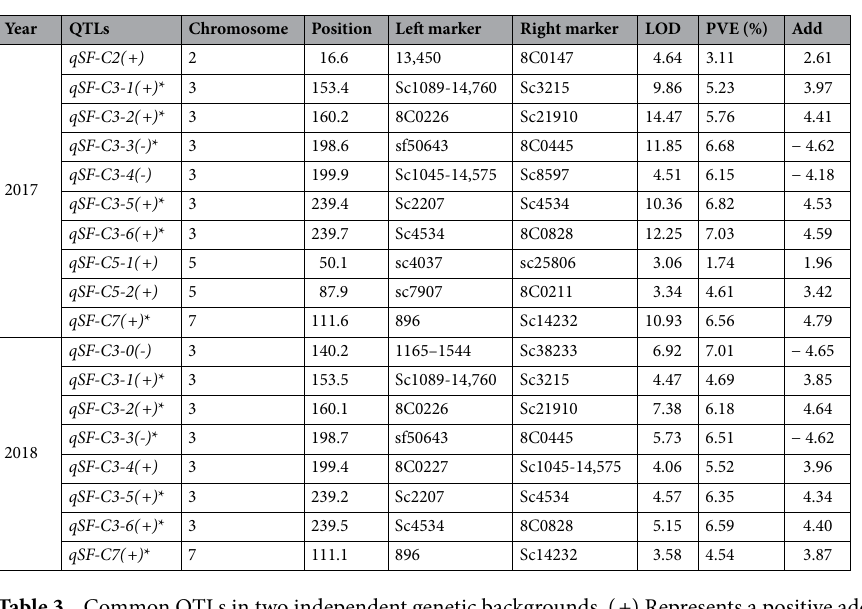
Table 3. Common QTLs in two independent genetic backgrounds. ( +) Represents a positive additive effect, indicating that the alleles at the locus increased the content of SF; (-) represents a negative additive effect, indicating that the alleles at the locus decreased the content of SF; PVE represents the phenotypic variance explained; Add represents the additive effect; *(in red) indicates an overlapping chromosomal region detected in the two years and considered to be the same locus.